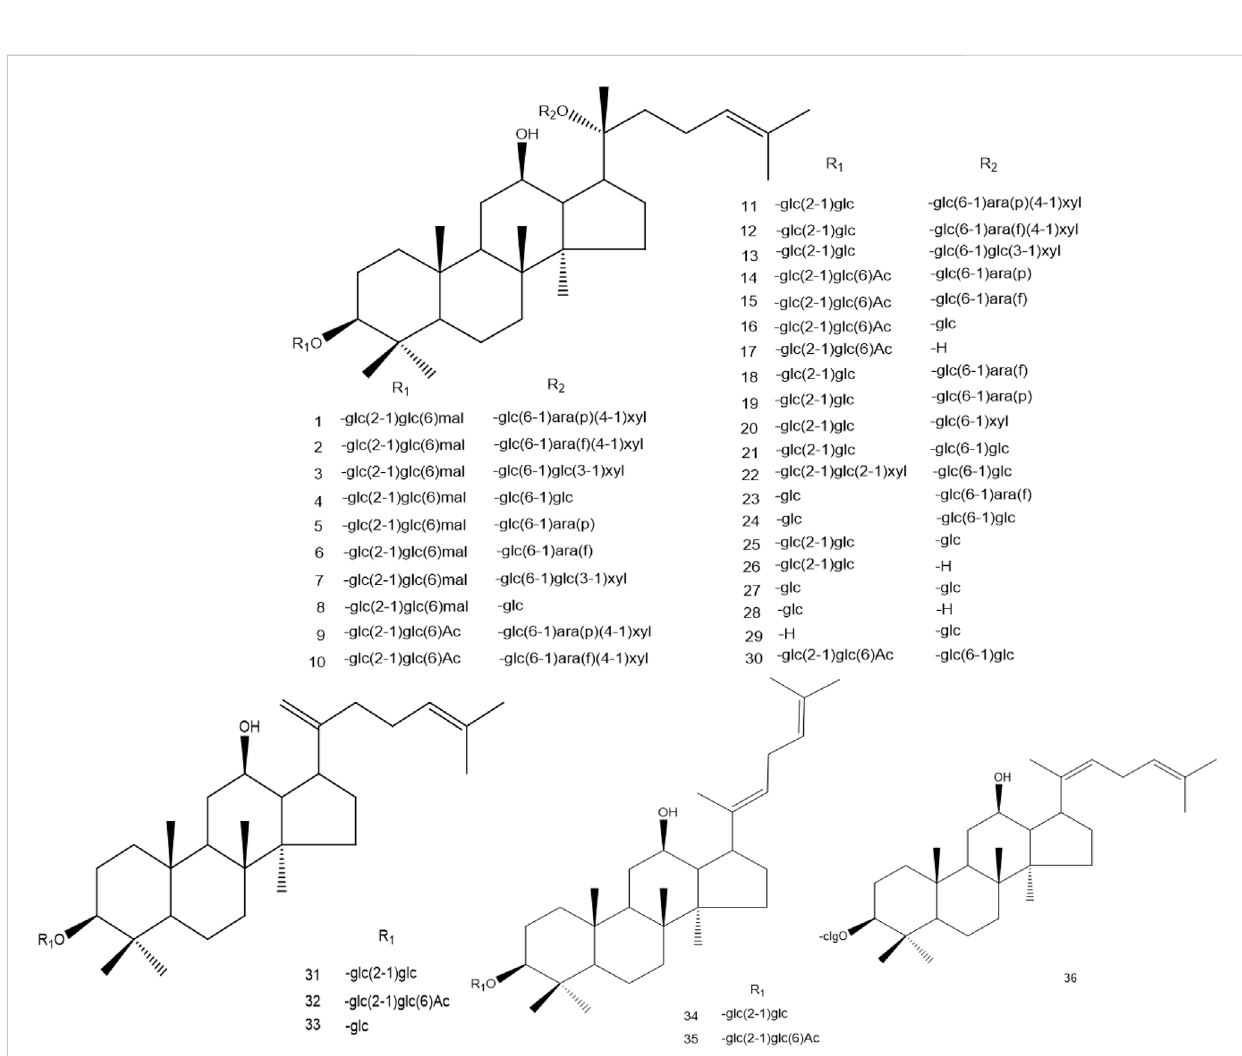
FIGURE 3 Structure of protopanaxadiol ginsenosides. (ara(f): α -L -arabinofuranosyl; ara(p): α -L -arabinopyranosyl; rha: α -L -ahamnopyranosyl; glc: β -D - glucopyranosyl; xyl: β -D -xylopyranosyl; mal:malonyl;